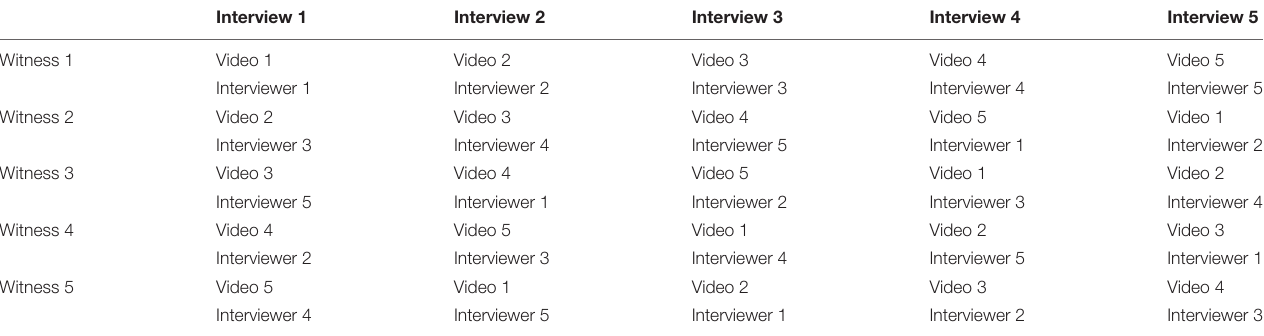
TABLE 1 | The schedule for each witness per round of the